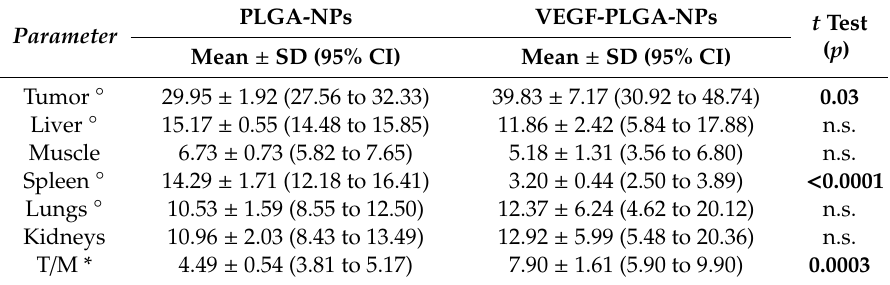
Figure 7. Comparative distribution of PLGA-NPs and VEGF-PLGA-NPs at 24 h post-injection (p.i.) in collected organs. Data are expressed as average fluorescence (NET/Area) ± SD of five different mice per group. Table 3. fluorescence (NET / Area) of di ff erent organs at 24 h p.i. of PLGA-NPs and VEGF-PLGA-NPs. PLGA-NPs Parameter